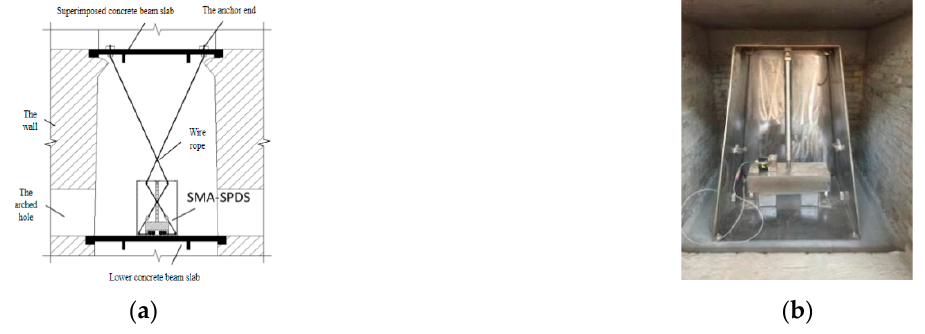
Figure 4. SMA-SPDS installation setup diagram. ( a ) SMA-SPDS connection; ( b ) SMA-SPDS installa-